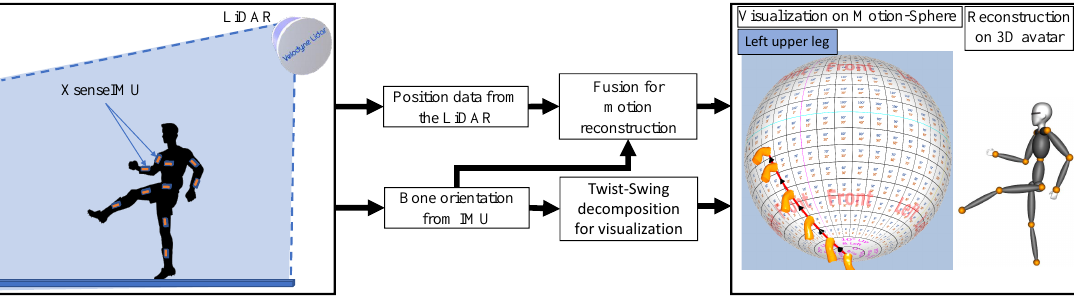
Figure 1. Overview of the proposed